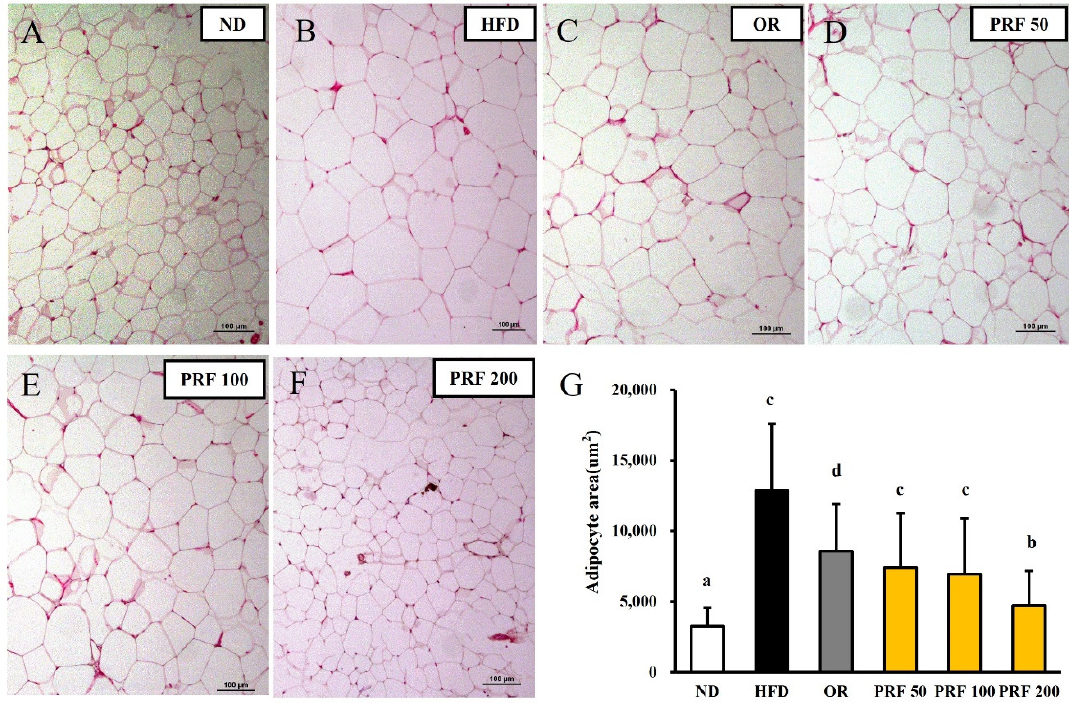
Figure 4. Effect of PRF on the size of epididymal adipocytes in HFD-induced obese mice. The sections of the epididymal fat tissues of ND ( A ), HFD ( B ), OR ( C ), PRF 50 ( D ), PRF 100 ( E ), and PRF 200 ( F ) were stained with H&E (100×). Scale bar = 100 µm. ( G ) The epididymal adipocyte sizes of each group. ND, normal diet; HFD, high-fat diet; OR, HFD + 15.6 mg of orlistat; PRF 50, PRF 100, and PRF 200, HFD + 50, 100, and 200 mg of PRF, respectively. The results are expressed as the means ± SDs ( n = 7). The values with different letters (a–d) are significantly different ( p < 0.05) from each other according to one-way ANOVA and Duncan’s multiple-range test.